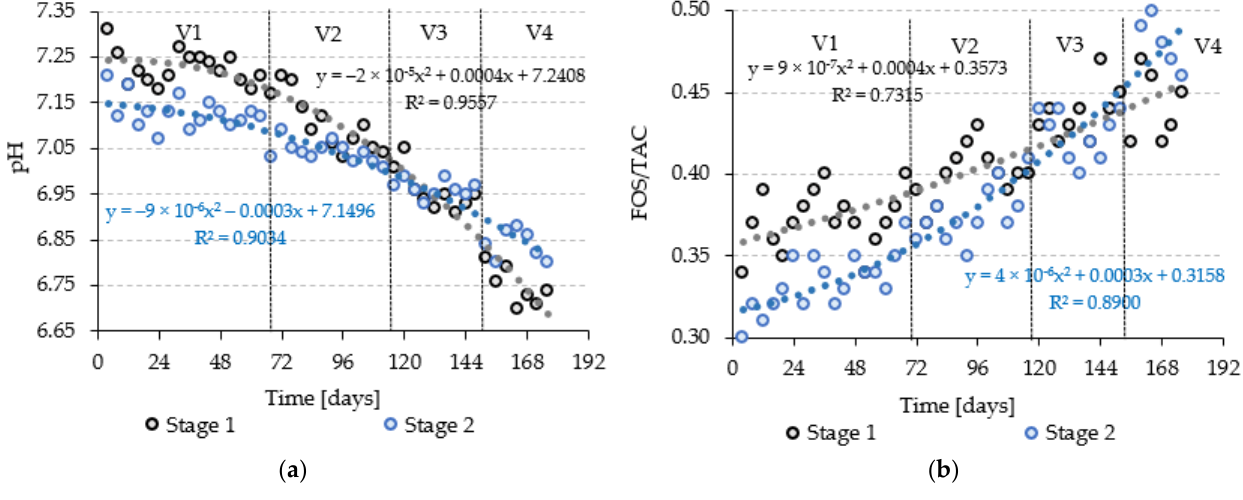
Figure 6. Trends in pH value ( a ) and FOS/TAC ratio ( b ) throughout the experiment.